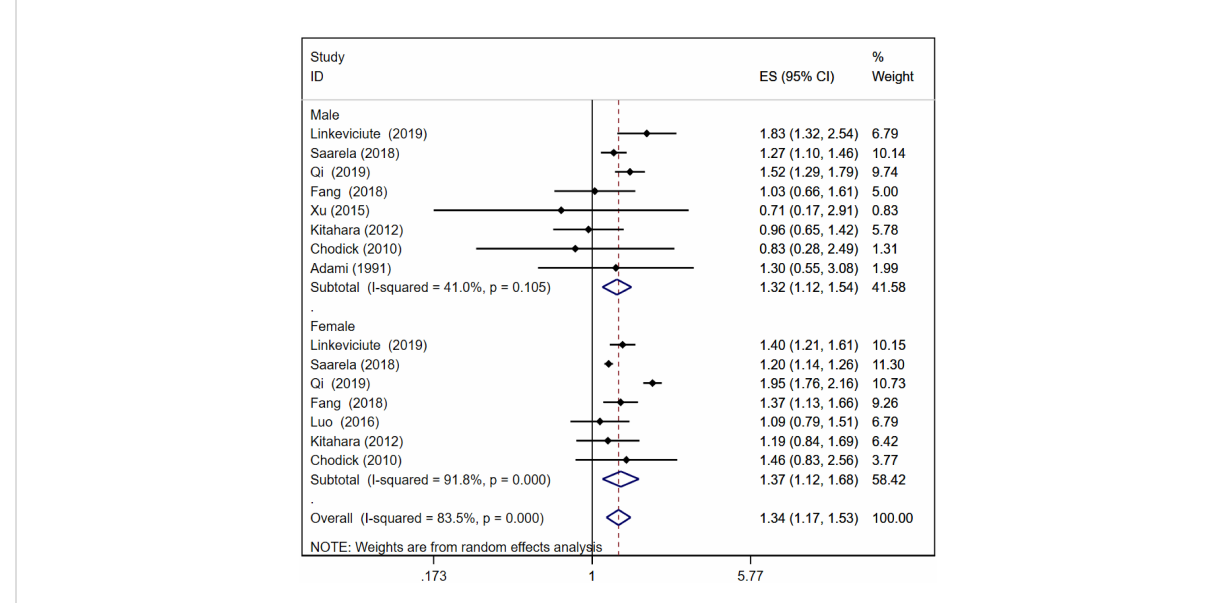
FIGURE 3 Forest plots of thyroid cancer risk in type 2